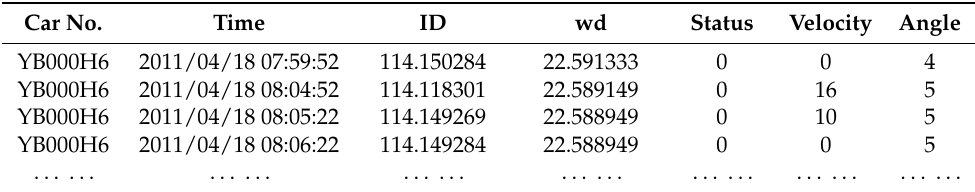
Table 11. GPS data format after the pre-processing procedure.